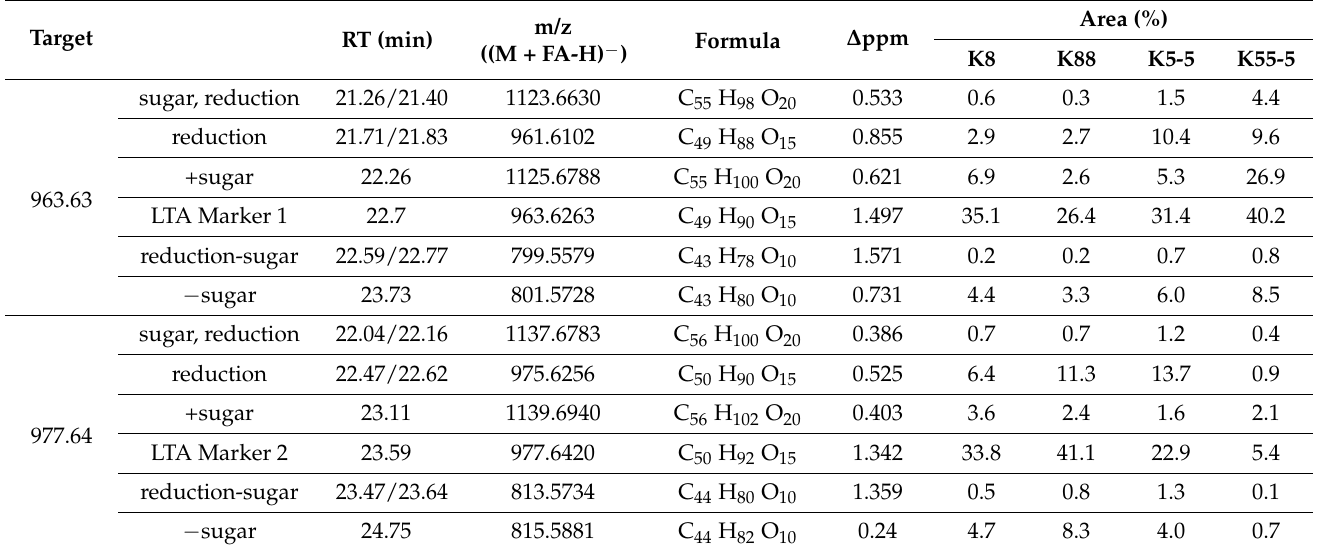
Figure 4. Predicted LTA glycolipid structures for derivatization. ( A ) LC-MS analysis of four LTAs. ( B ) Predicted LTA glycolipid structures for derivatization. Table 2. LC-MS analysis. Relative peak area of two markers isolated from four kinds of